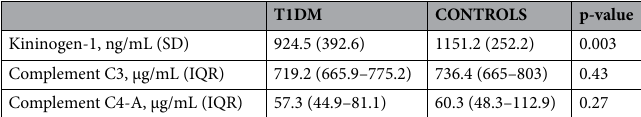
Table 5. Serum concentrations of selected proteins